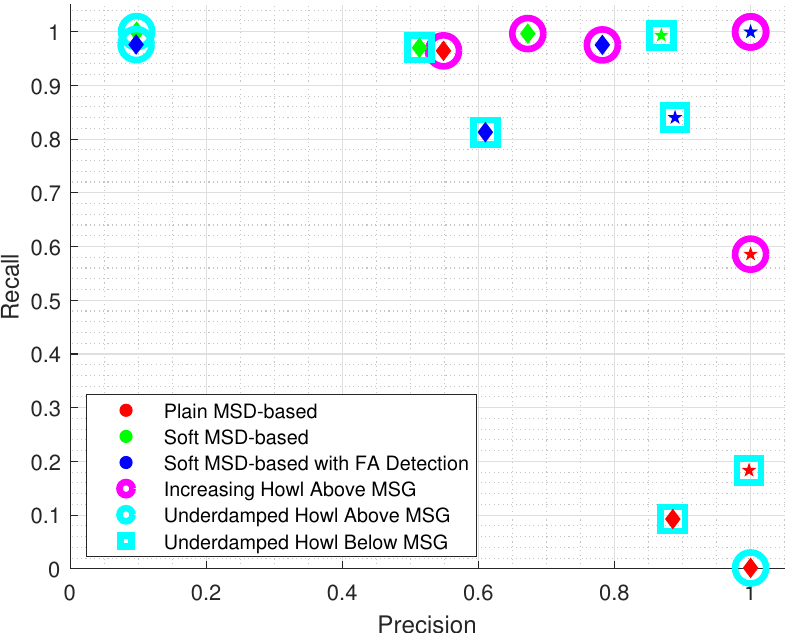
Figure 8. Summarized detection accuracy performance evaluation graph. The simulated car cabin results are marked by a pentagram, and the simulated study room results are marked by a